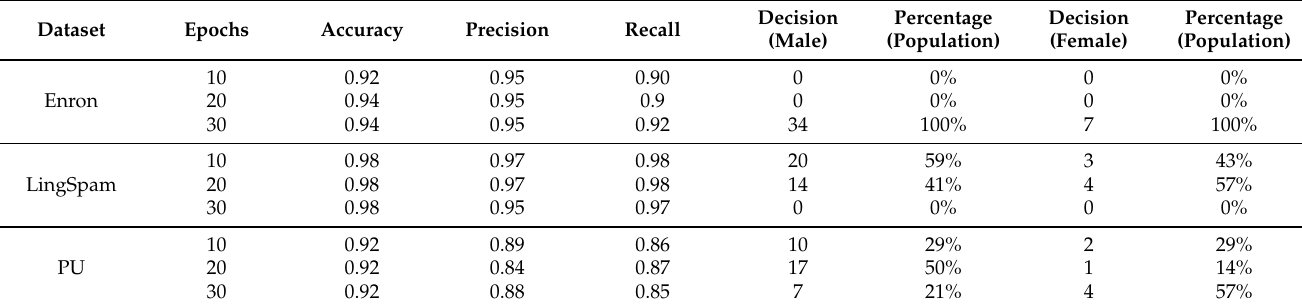
Table 7. Summary of extrinsic evaluation for the BERT model.